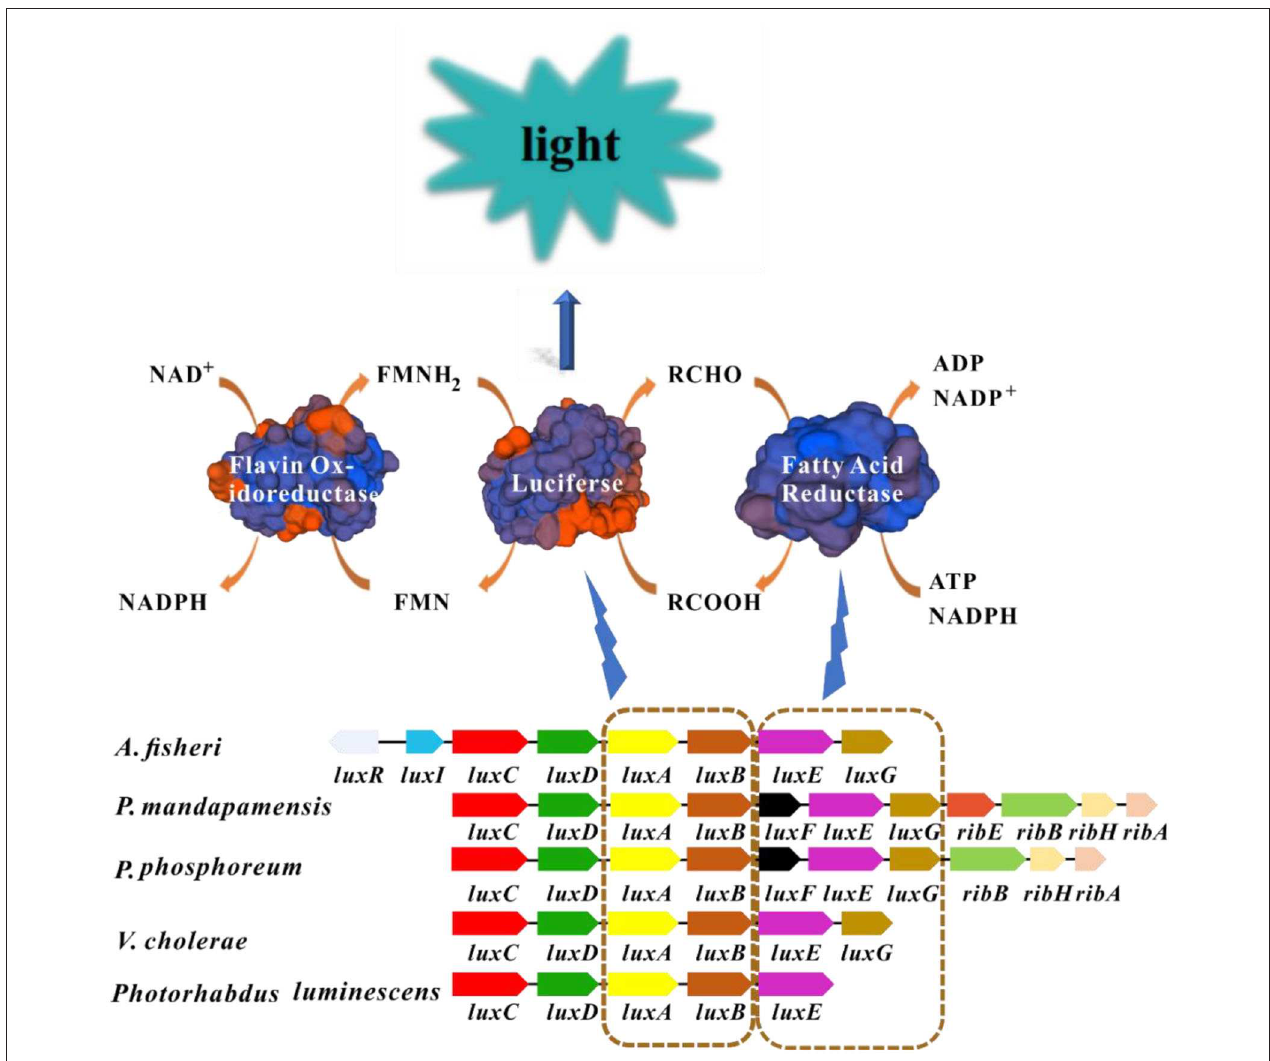
FIGURE 1 | Luminescence mechanism of luminescent bacteria. Blocks with the same color in different bacteria represent homologous genes. The luxA and luxB encode luciferase, luxC , luxD, and luxE encode the fatty acid reductase complex. The structures of enzymes in this picture are modeled by SWISS-MODEL (https://www.swissmodel.expasy.org/). FMNH 2 and long-chain fatty aldehyde are oxidized by luciferase enzyme into FMN and long chain fatty acid, respectively. This process is accompanied by the production of blue-green